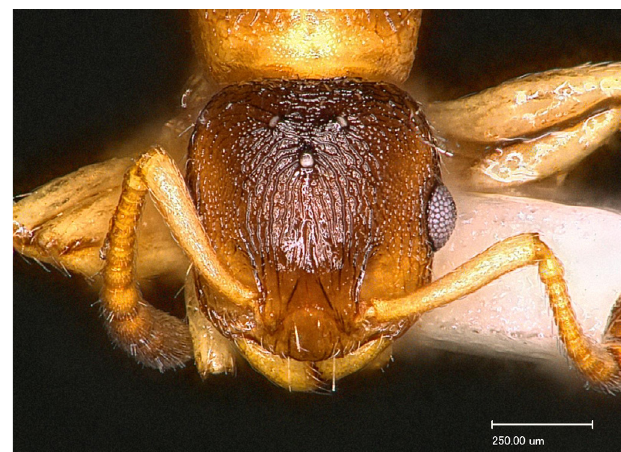
Fig 4 . Head of a female sexual of the inquiline ant Leptothorax kutteri from Arsiyan Plateau in frontal view, Turkey.